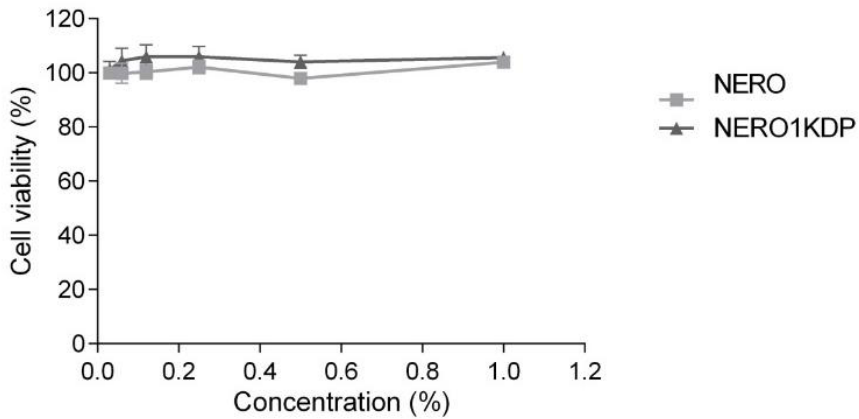
Figure 8. Fibroblast (3T3-L1) cell viability after 24 h of treatment with unloaded nanoemulsion (NERO) and 1 mg/mL kojic dipalmitate (KDP)-loaded nanoemulsion (NERO1KDP) at concentra- tions ranging from 0.06% to 1%. No significant differences ( p > 0.05) were observed between sam-